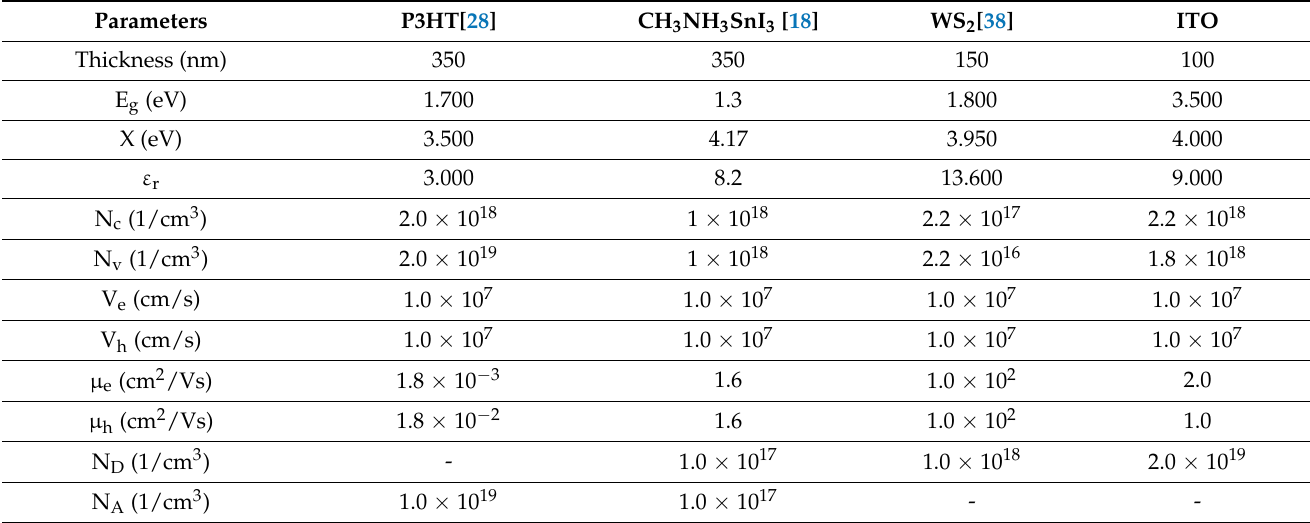
Table 1. Simulation parameters of each layer of the proposed device